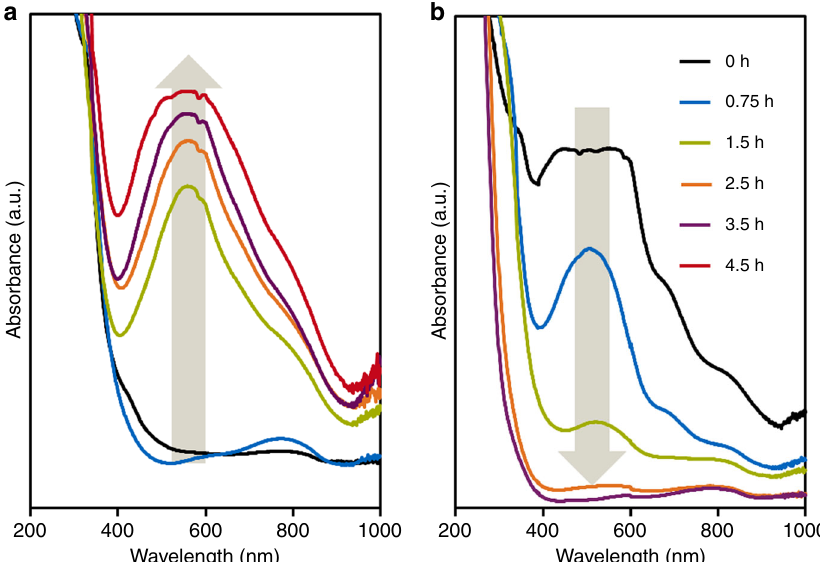
Fig. 6 UV-Vis spectra of fi ltrates extracted from MoVTeNb hydrothermal slurries. Synthesis according to the procedure presented in this work in presence of additives ( a ); and synthesis according to procedure presented in ref. 19 ( b Fig. 7. Under hydrothermal conditions, the metal concentrations in solution in the new synthesis method increased with time (Fig. 7a).